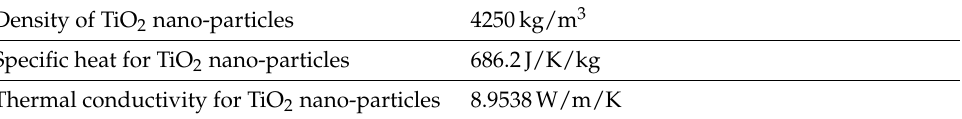
Table 4. Default values for Titanium Oxide.